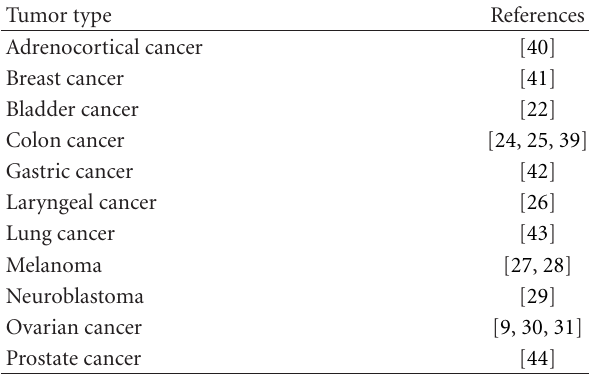
Table 3: Human tumors expressing